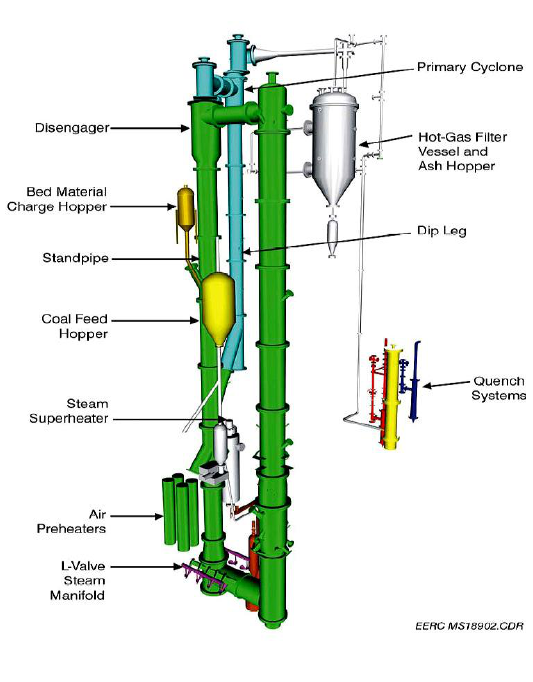
Figure 10. KBR Transport Gasifier [1].